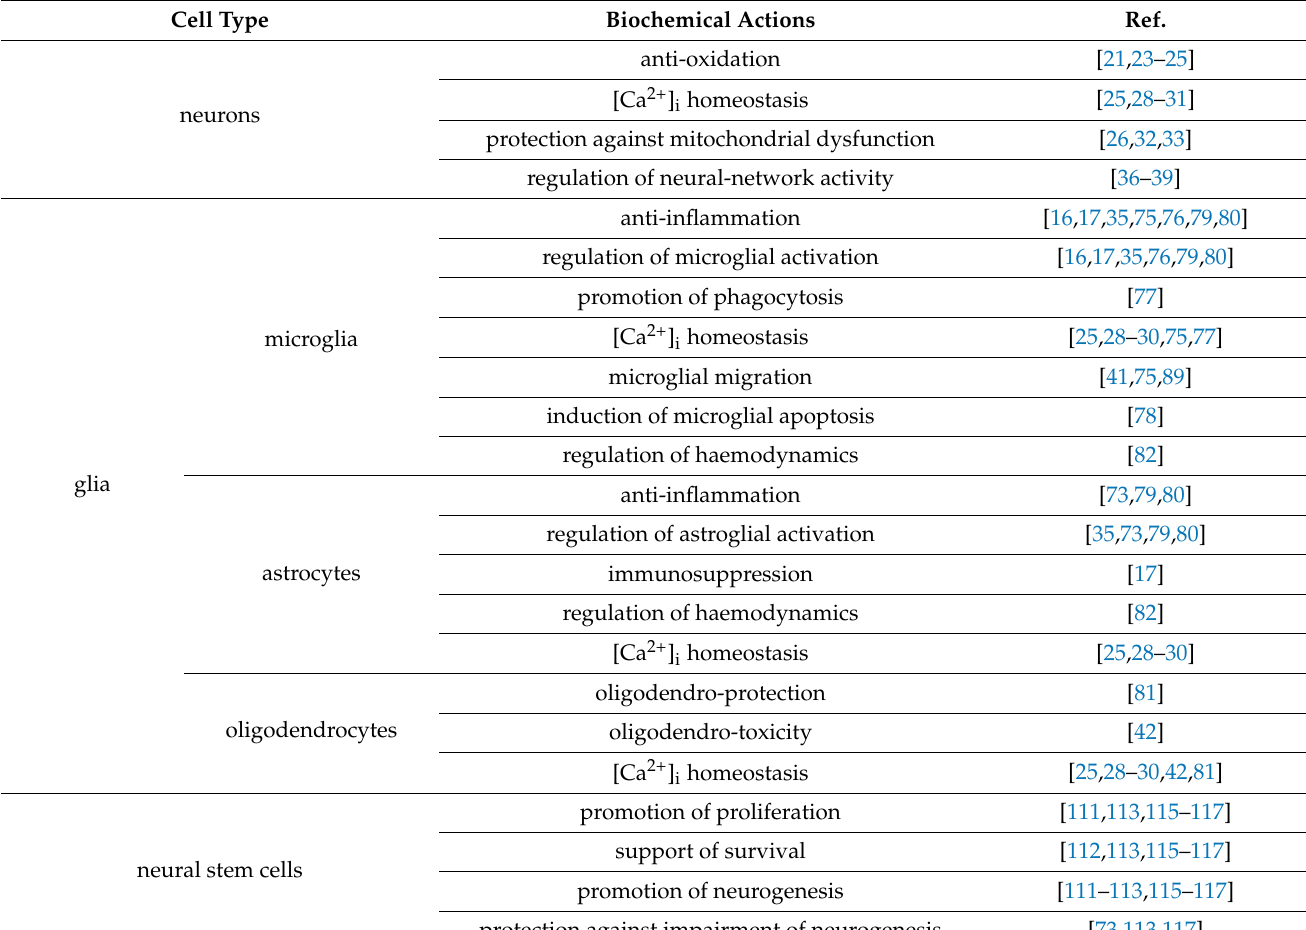
Table 4. Summary for reported biochemical actions of CBD in neural